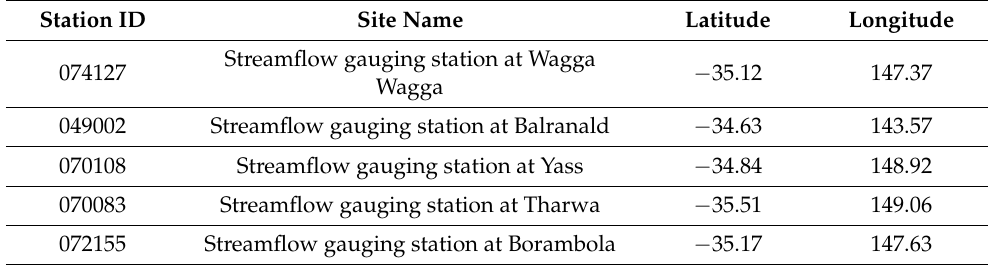
Table 1. The Murrumbidgee River sub-catchment’s location and streamflow gauging station details. Station